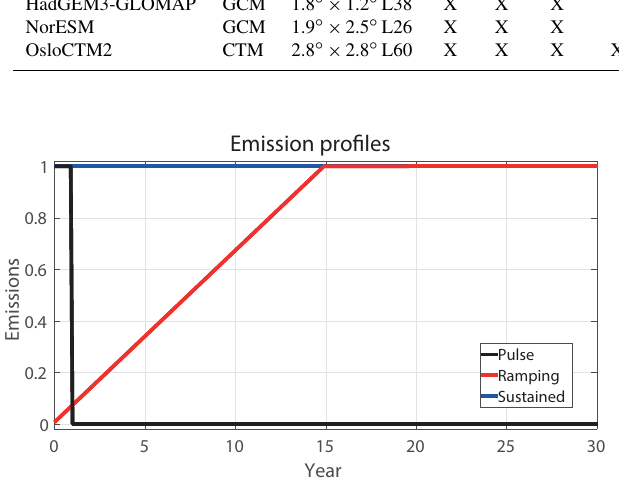
Figure 1. Pulse, sustained, and ramping emission profiles. The ramping period can